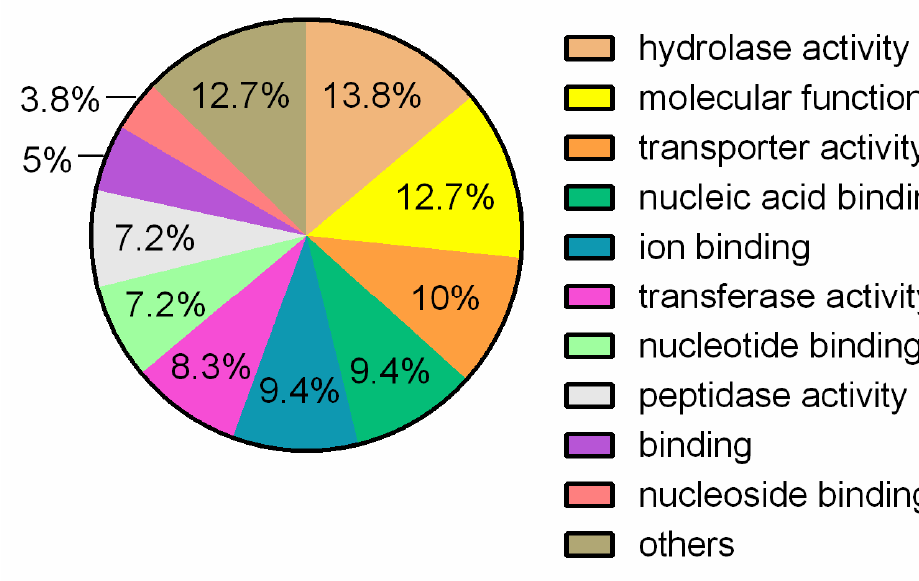
Figure 6. Cell components related to proteins belonging to the shared clusters of L. fermentum strains ATCC 23271, 2760, 3872, CECT 5716, AGR 1485 and DR 9.